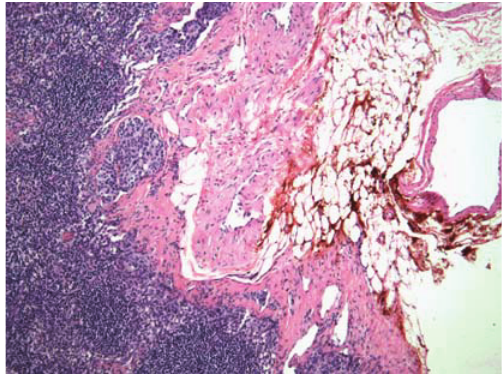
Figure 2: Micrometastases located in hilum close to hotspot.